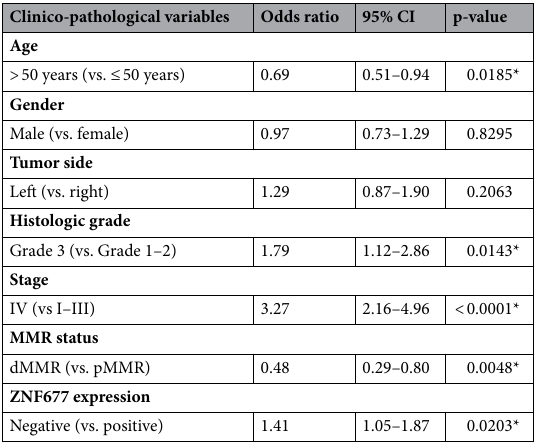
Figure 2. Survival analysis of ZNF677 protein expression in colorectal carcinoma (CRC). Kaplan Meier survival plot showing no statistically significant difference between ZNF677 positive and negative tumors for ( A ) distant disease-free survival ( p = 0.6931), ( B ) CRC-specific survival ( p = 0.3770) and ( C ) overall survival ( p = 0.8307). Clinico-pathological